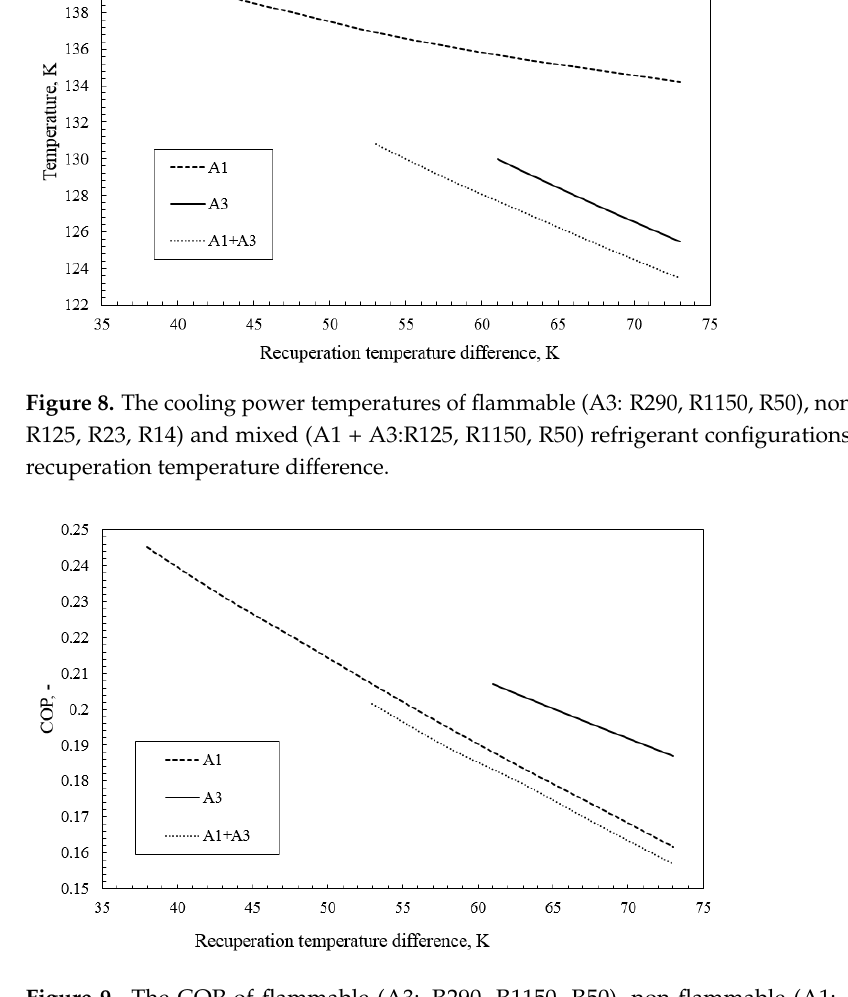
Figure 9. The COP of flammable (A3: R290, R1150, R50), non-flammable (A1: R125, R23, R14) and mixed (A1 + A3:R125, R1150, R50) refrigerant configurations with respect to the difference in recuperation